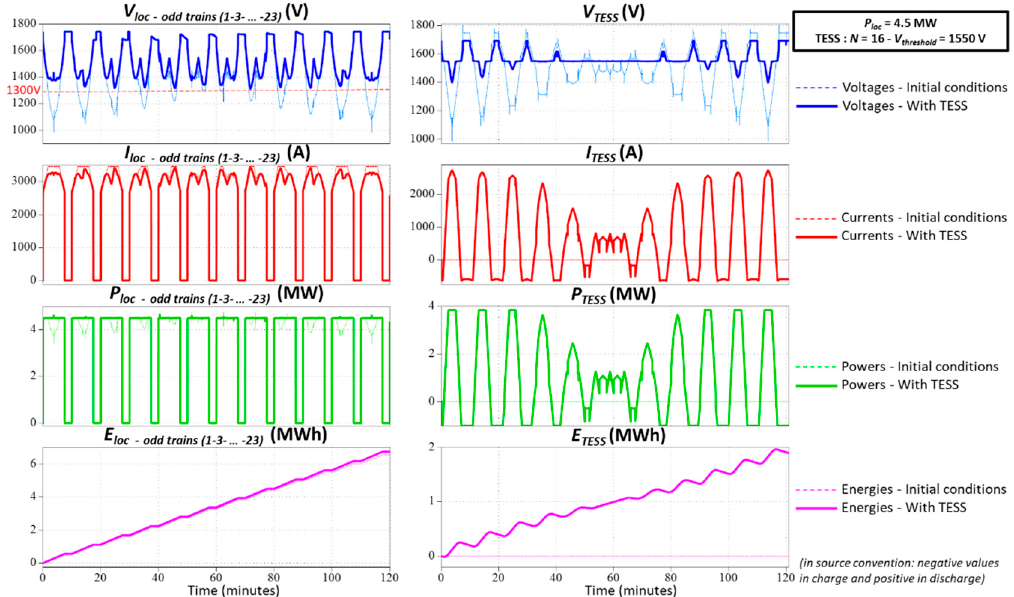
Figure 13. Simulation results with the circulation of 23 trains over a time span of 2 h (peak period); initial conditions and with TESS.